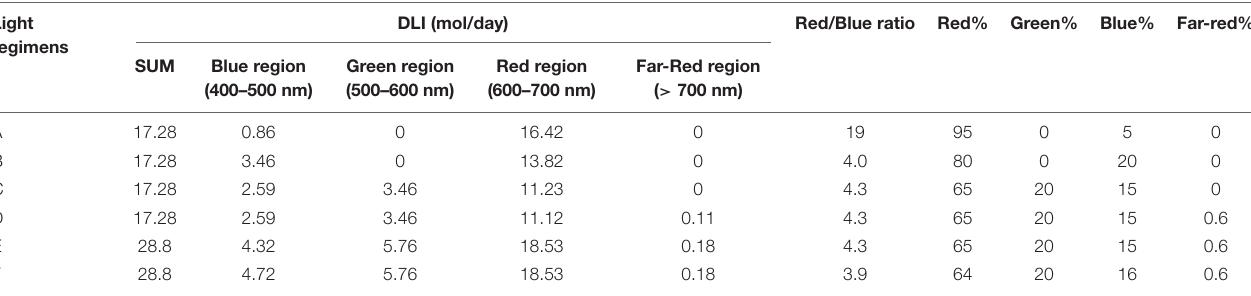
Light regimens used: Regimen A, red and blue LEDs were used with a 95:5 ratio at moderate (300 µ mol m − 2 s − 1 ) light intensity; Regimen B, utilisation of red and blue LEDs with an 80:20 ratio at moderate (300 µ mol m − 2 s − 1 ) light intensity; Regimen C, a wide spectrum (containing white, red, and blue LEDs) in an average proportion of 65:20:15 of red:green:blue at moderate (300 µ mol m − 2 s − 1 ) light intensity: Regimen D, a wide spectrum supplemented with far-red application in an average proportion of 65:20:15:0.6 of red:green:blue:far-red at moderate (300 µ mol m − 2 s − 1 ) light intensity; Regimen E, a wide spectrum supplemented with far-red application in an average proportion of 65:20:15:0.6 of red:green:blue:far-red at high (500 µ mol m − 2 s − 1 ) light intensity; Regimen F, a wide spectrum supplemented with far-red and blue light application in an average proportion of 64:20:16:0.6 of red:green:blue:far-red at high (500 µ mol m − 2 s − 1 ) light intensity. The total photosynthetic photon flux density (PPFD) integrated between 400 and 750 nm and the spectral distribution were determined by PG200N Spectral PAR Meter (Uprtek Europe Dl Technology GmbH, Aachen, Germany), where the blue region was integrated between 400 and 500 nm, the green region between 500 and 600 nm, the red region between 600 and 700 nm, and the far-red region between 700 and 750